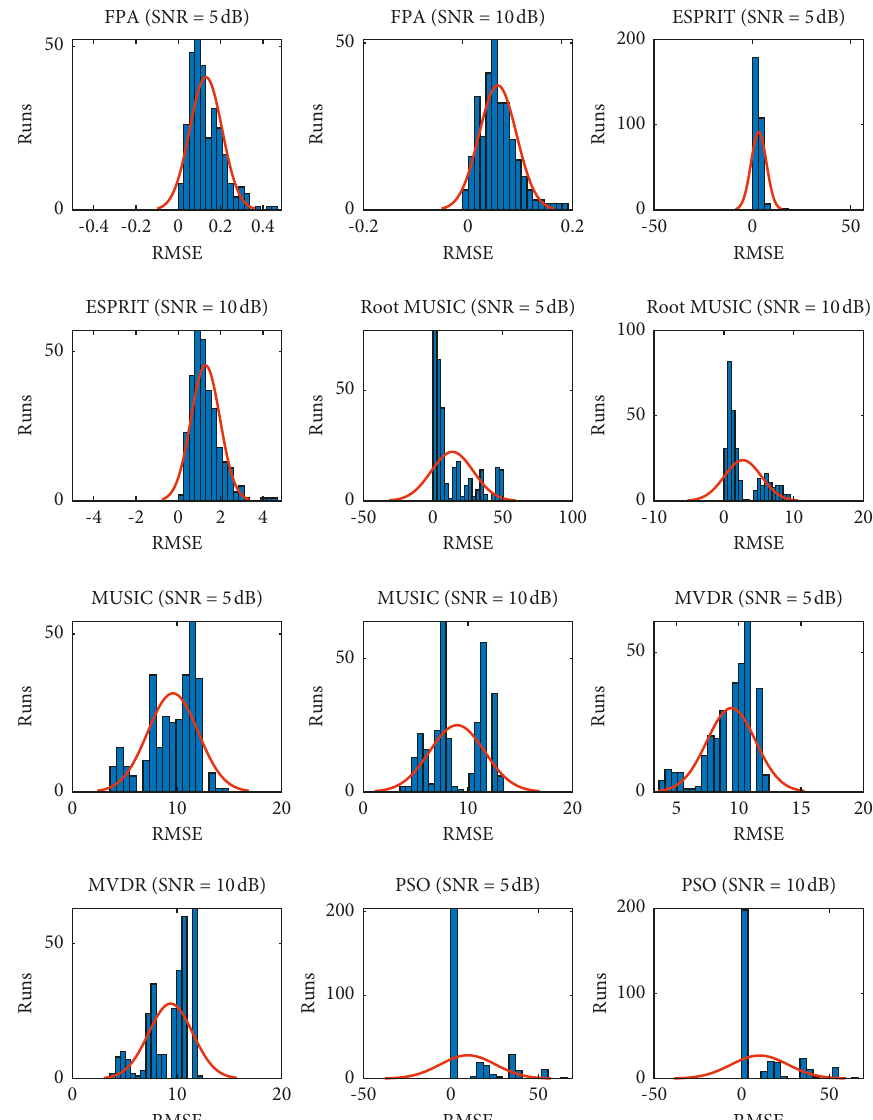
Figure 18: Histogram analysis of RMSE for three